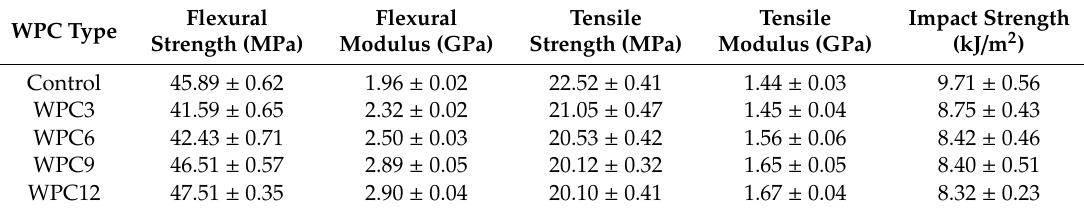
Table 3. Mechanical properties WPCs adding